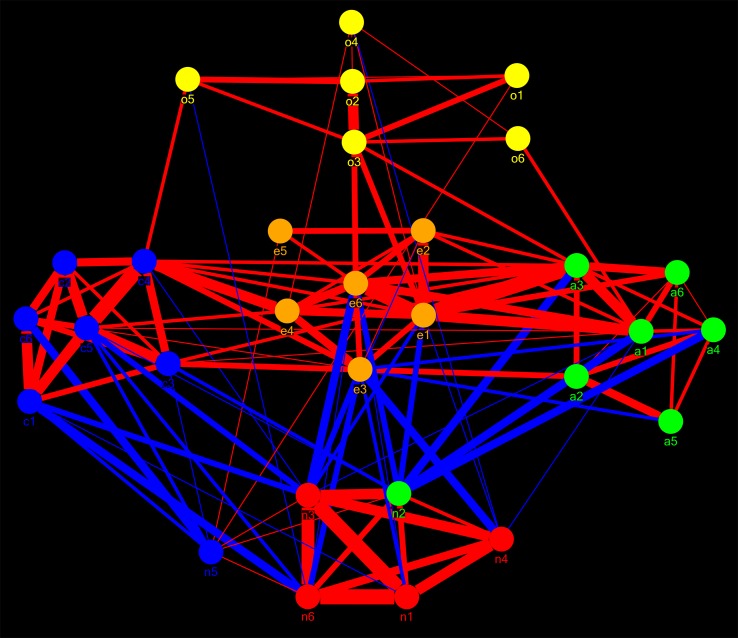
The Personality Web at facet level: network graph of correlational relationships between the 30 facets of the NEO-PI-R.The community structure of this graph has an overall best fit with the confirmatory 5-FS, occurring at r>0.271, p<4.89 E-09. See Table 2 for significances and correlation coefficients. Node = facet, link = significant correlation. Red links: positive correlations. Blue links: negative correlations. The thickness of the links represents the strength of the correlation. For further information, see Table 4B. n = neuroticism, e = extraversion, o = openness, a = agreeableness, c = conscientiousness. Numbers refer to facet number. Nodes are positioned in clusters according to their factor membership (standard 5-FS). The color of nodes denotes their network cluster membership. Only two facets show a mismatch with the standard 5-FS (n5 and n2). Both mismatches involve the neuroticism dimension depicted below in red. These facets have strong correlations with facets from the conscientiousness cluster (blue) and the agreeableness cluster (green), as can be observed by the thickness of the corresponding links. As a result, n5 is “drawn” into the conscientiousness cluster and n2 into the agreeableness cluster.